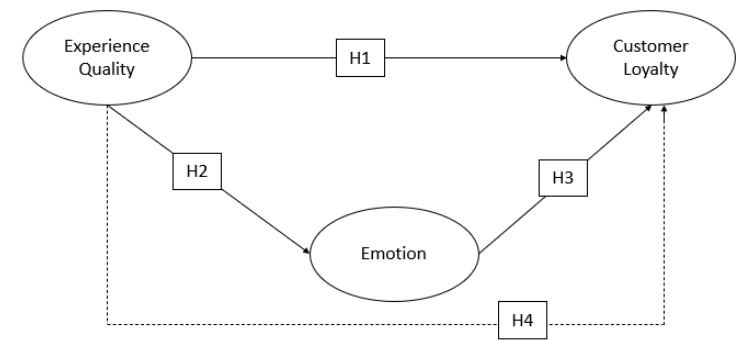
Figure 1: Research Framework and